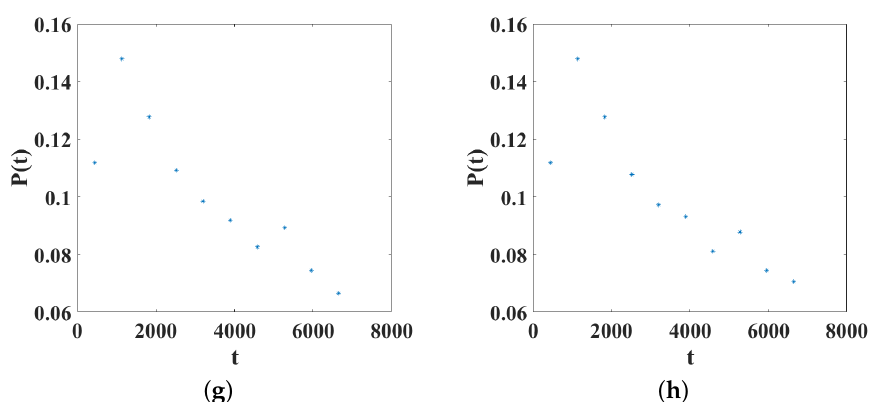
Figure 10. Probability distributions of time settling with changes in k 2 . ( a ) k 2 = 0.6; ( b ) k 2 = 0.7;